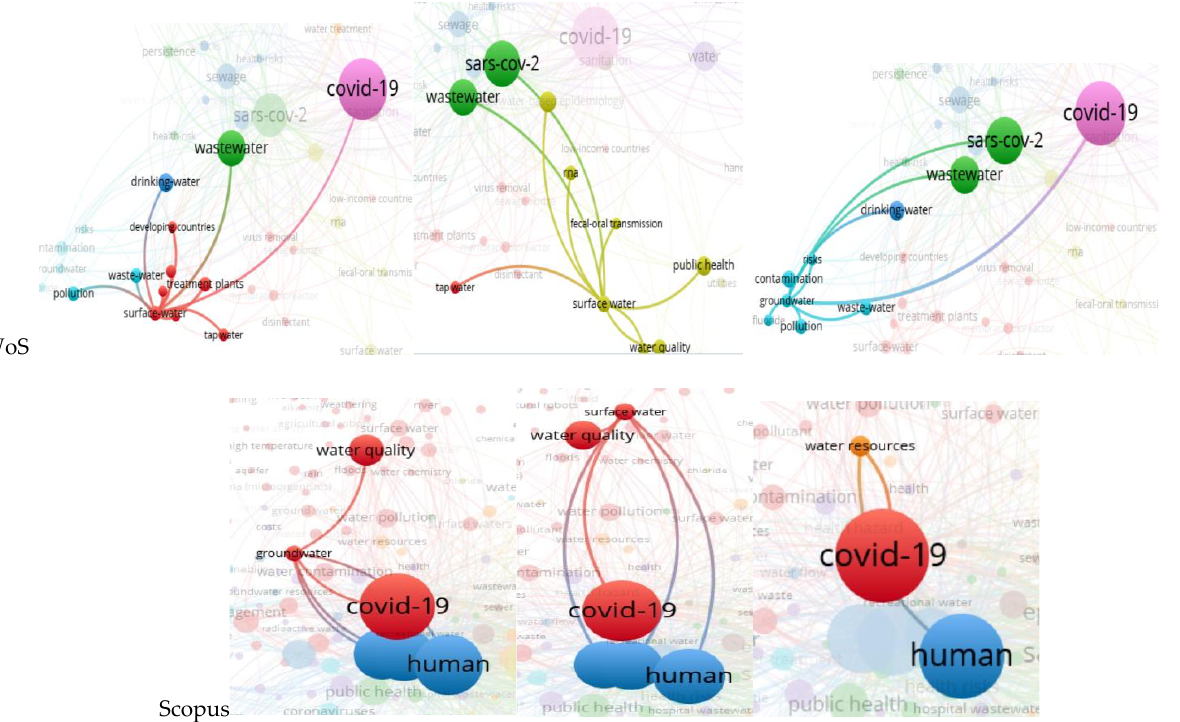
Figure 4. Relationships between renewable water resources (surface water and groundwater), water quality, humans, and COVID-19.